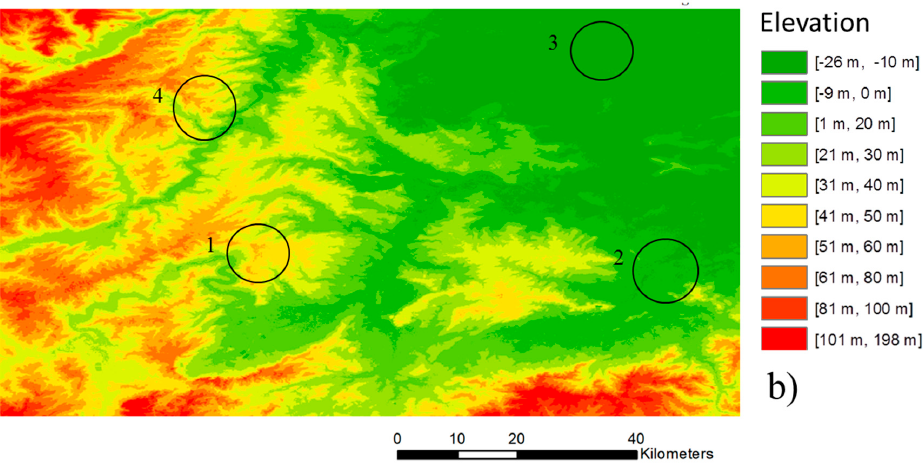
Figure 3. DEMs of the study area: ( a ) Ordnance Survey DEM; and ( b ) SRTM 30 DEM.